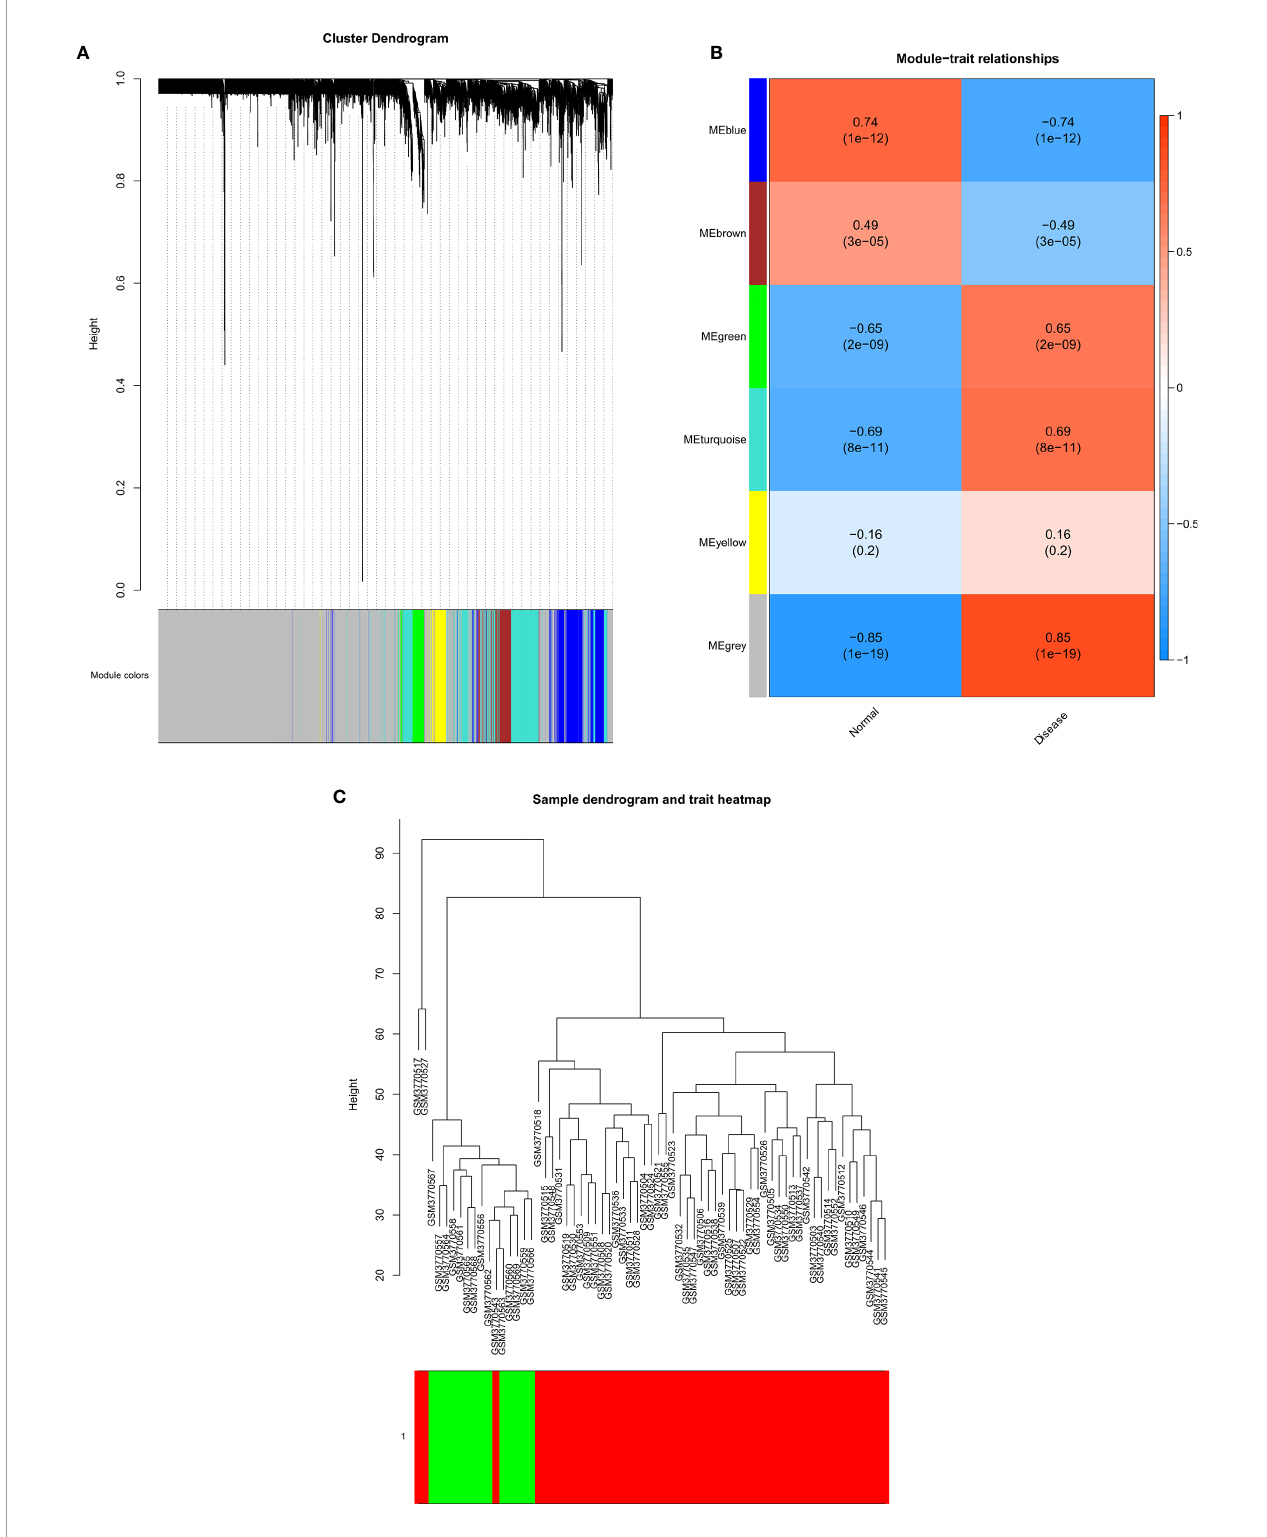
FIGURE 4 | Gene modules identi fi ed by WGCNA. (A) Cluster dendrogram of the coexpression network modules; (B) Gene relation between hepatoblastoma and normal samples; (C) Cluster tree of hepatoblastoma and normal